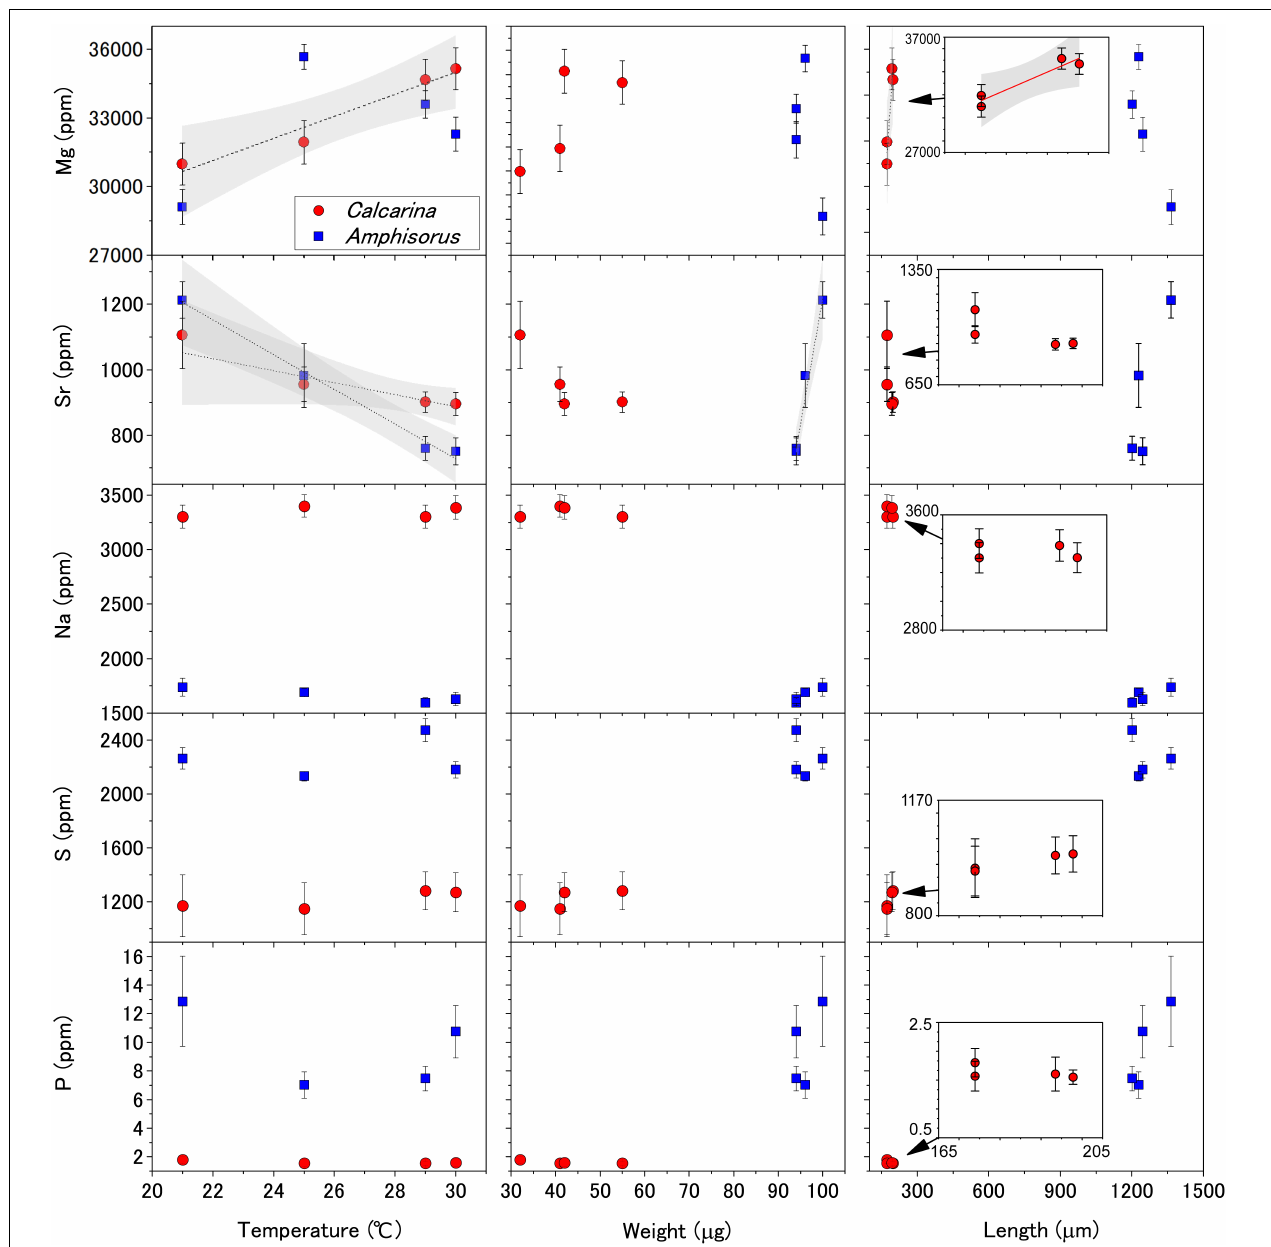
FIGURE 1 | Plots of average test Mg, Sr, Na, S, and P concentrations measured by µ -XRF plotted against culture temperature, test weight, and length. The errors in each X -axis fall within the symbols. Gray areas represent 95% confidence bands of significant correlations ( p <